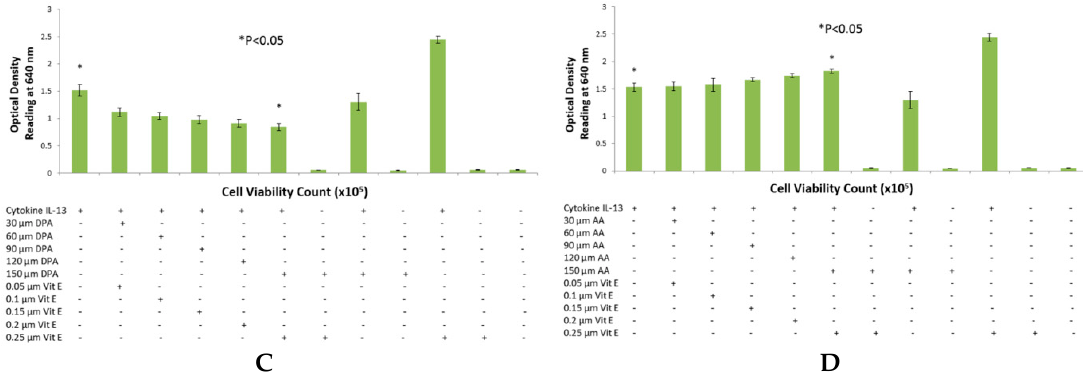
Figure 2. IL-13 detection assay with n-3 and n-6 fatty acids ( μ M) with HEK-Blue Cells using Quanti-Blue. ( A ) shows a dose-response inhibition of SEAP by DHA; ( B , C )depict the detection assay performed with EPA and DPA, respectively, with a dose-dependent inhibition of SEAP secretion from HEK-Blue cells; However, ( D ) with higher concentrations of AA, there is a rise in SEAP levels hence, and thus a higher optical density reading. n-3 fatty acids showed no abnormal effects on SEAP secretion without vitamin E. However, AA without vitamin E caused higher than SEAP secretion than the positive control. * p < 0.05 denotes significance of optical density readings compared to positive control (PC).